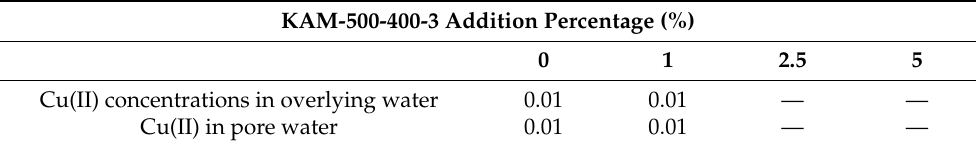
Table 1. Effect of KAM-500-400-3 addition percentage on Cu(II) concentrations in overlying water and pore water of Cu(II)–Cd(II) mixed contaminated sediment.